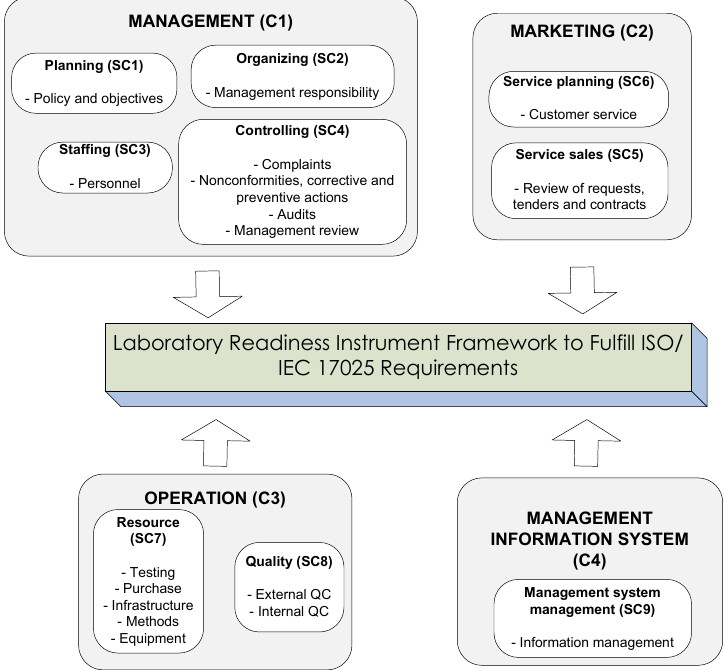
Figure 1. Instrument framework for assessing laboratory readiness.